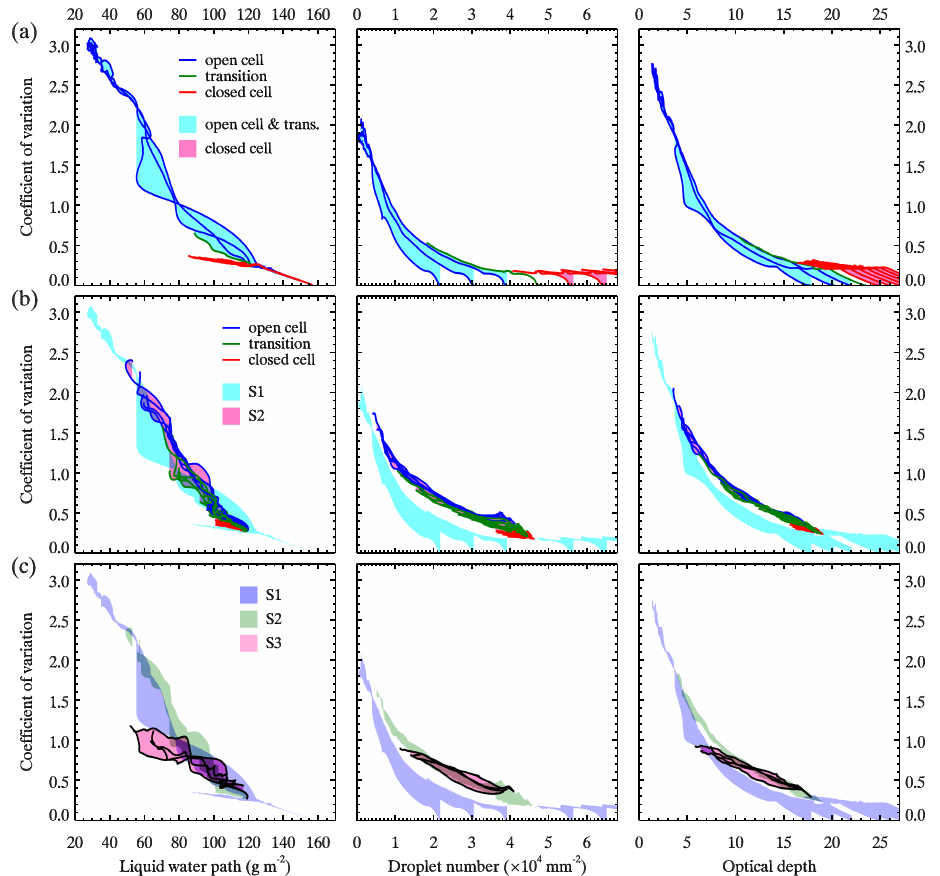
Figure 11. (a) Phase diagram of c v of LWP, N d , and τ for all S1 cases. The two shadings cover the range of c v for open-cell and transition cases and for closed-cell cases. (b) Same as (a) but for all S2 cases. The two shadings are for S1 and S2. (c) Same as (a) but for all S3 cases. The S3 analysis is applied for the subdomain with 51.2km width. The three shadings are for S1, S2 and S3. All shadings are translucent. A 15min running mean is